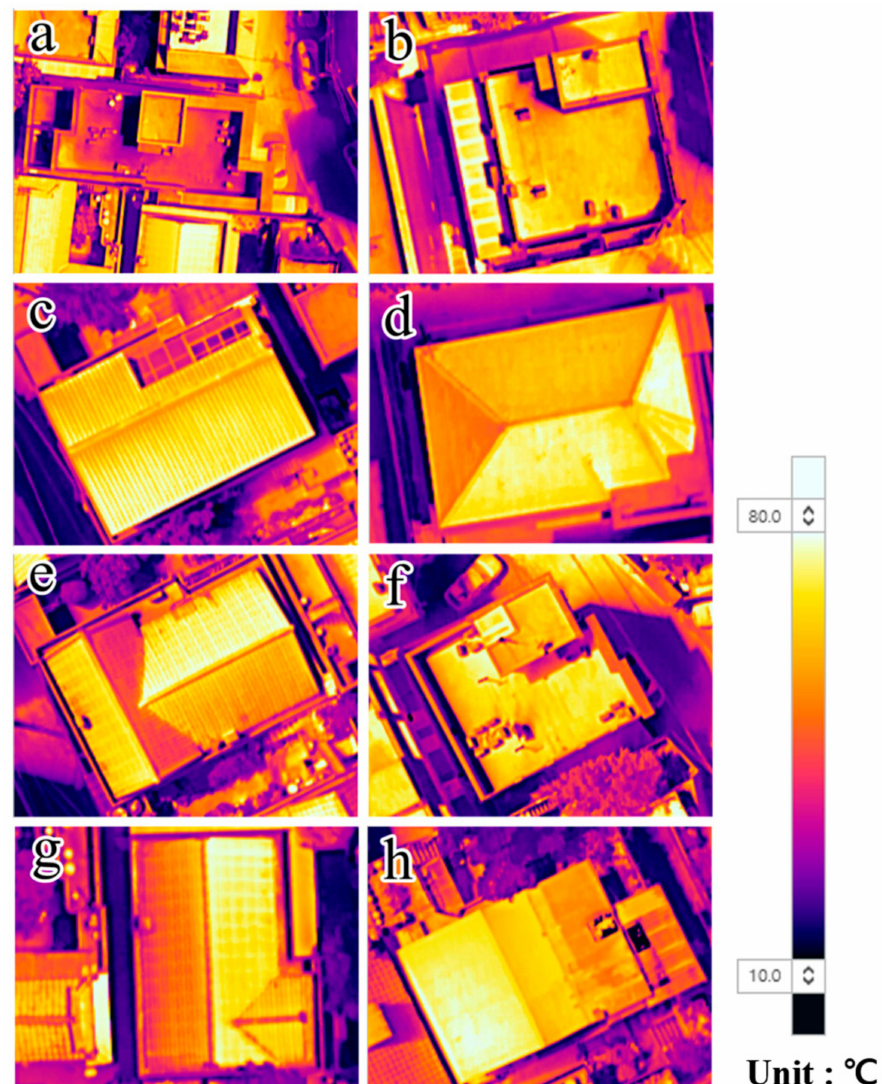
Figure 5. Surface temperature of sample rooftops acquired from thermal infrared imagery: ( a ) white, ( b ) gray, ( c ) blue, ( d ) cyan, ( e ) red, ( f ) green, ( g ) black, and ( h )